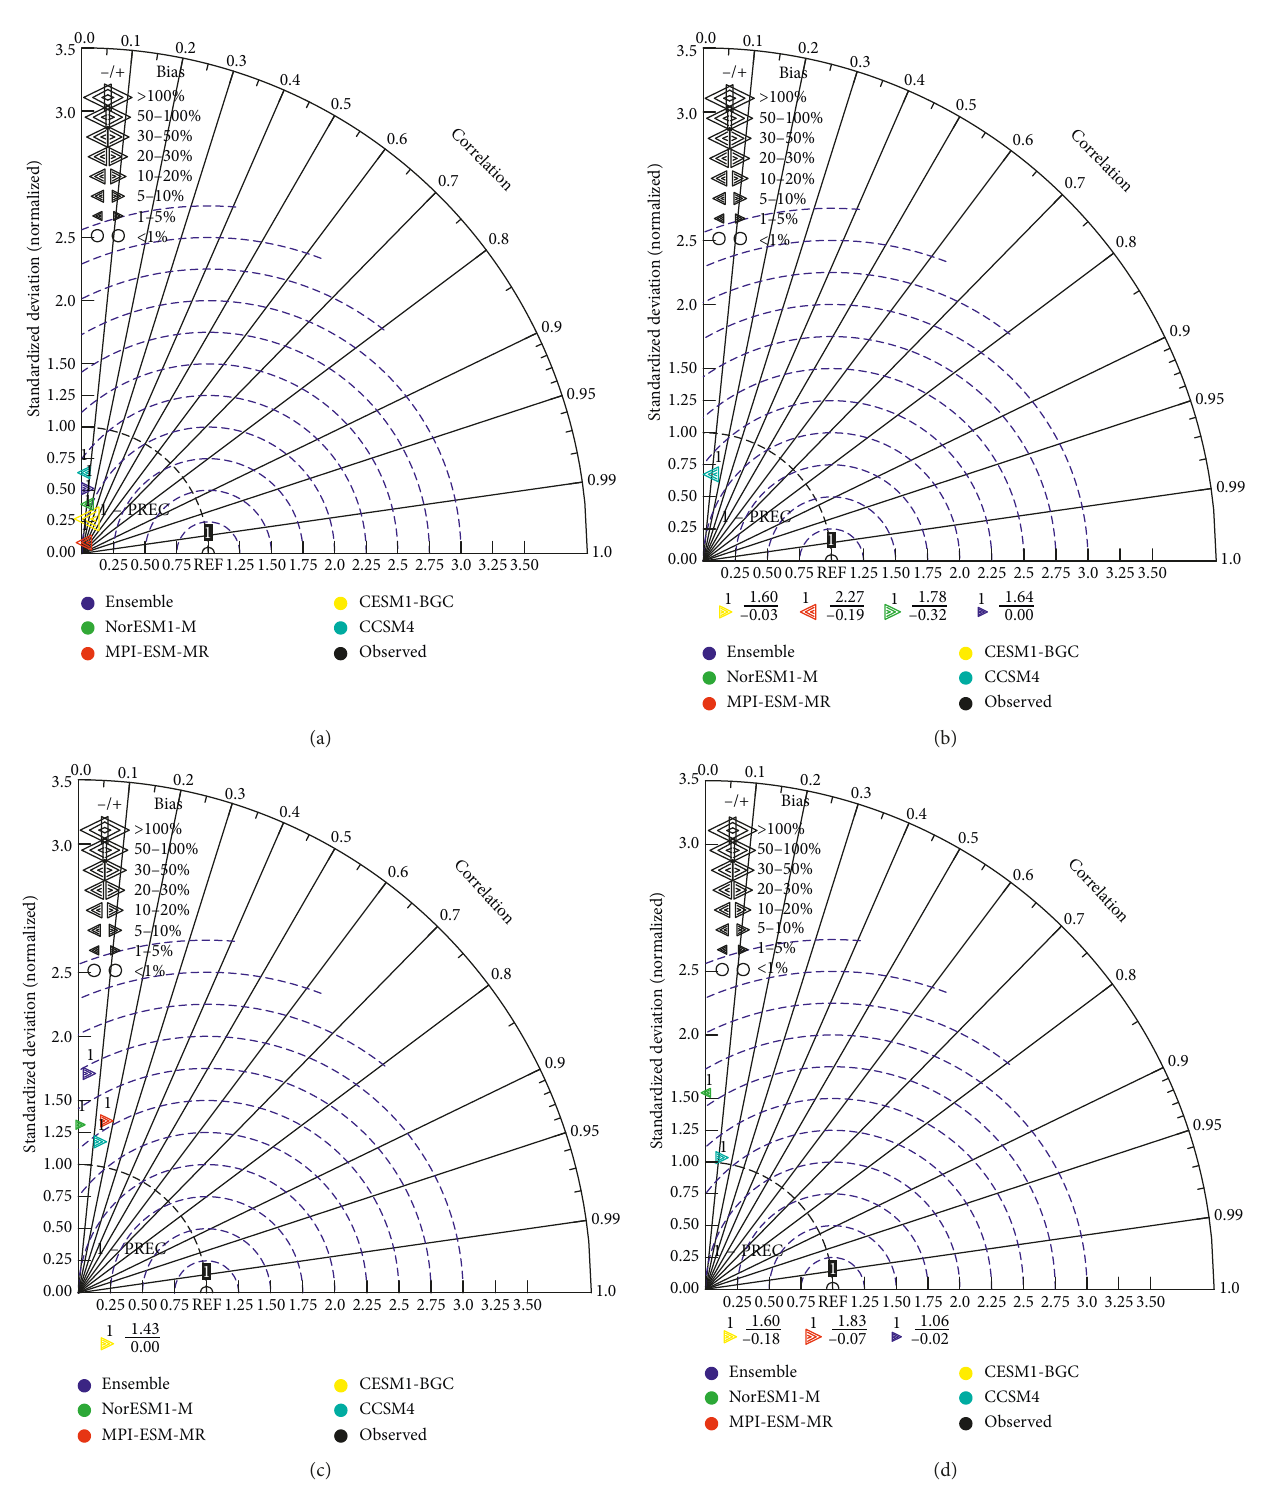
Figure 9: Taylor diagram for the Volta Basin showing the normalized standard deviation, the correlation, and the RMSE representing the variability, pattern, and errors, respectively, within the models and the reference data: DJF (a); MAM (b); JJA (c); SON